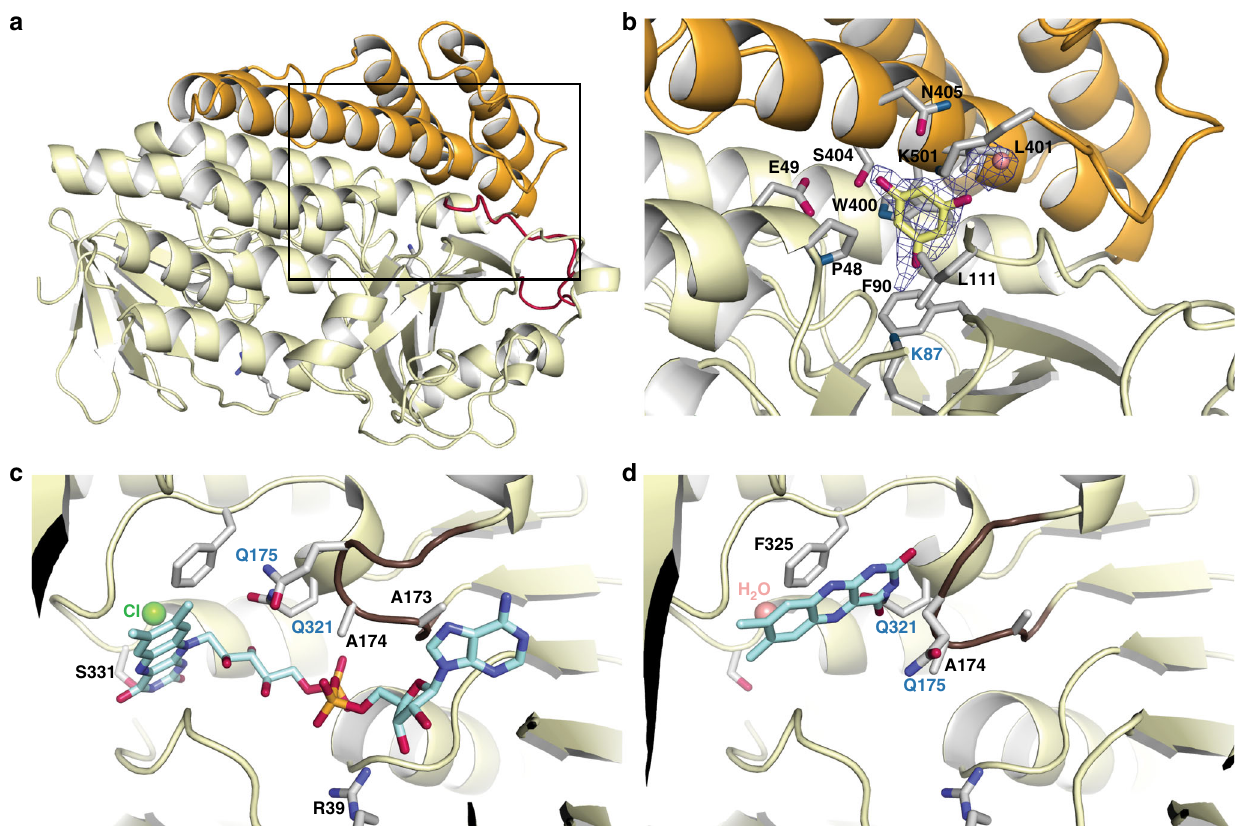
Fig. 4 Crystal structures of PltM. a Full view of the structure of PltM with the conserved halogenase fold in pale yellow and the unique C-terminal region in orange. The red loop indicates the N-terminal unconserved region after the 3rd β -sheet. The substrate binding region is shown by a box. b A zoomed in view of the substrate binding site of the structure of PltM-compound 1 complex (yellow sticks). Residues lining the substrate binding pocket are shown as gray sticks and the mF o – DF c polder omit map contoured at 5.5 σ is shown by the gray mesh. c The FAD bound in the holoenzyme state of PltM. d The FAD bound in a putative FAD binding intermediate state. FAD is represented as turquoise sticks in panels c and d . The fl exible loop that changes conformation upon FAD binding is shown in brown. Key FAD interacting residues are shown as sticks. Bound Cl − and water are shown as green and salmon spheres,